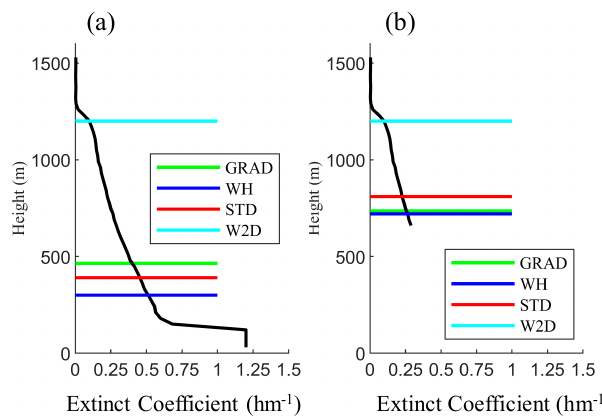
Figure 6. Vertical profiles and the ML heights calculated by different methods at 16:30 December 20, 2013: ( a ) using the original data; ( b ) using the data after quality control. The black solid line is the vertical profile of extinct coefficients.